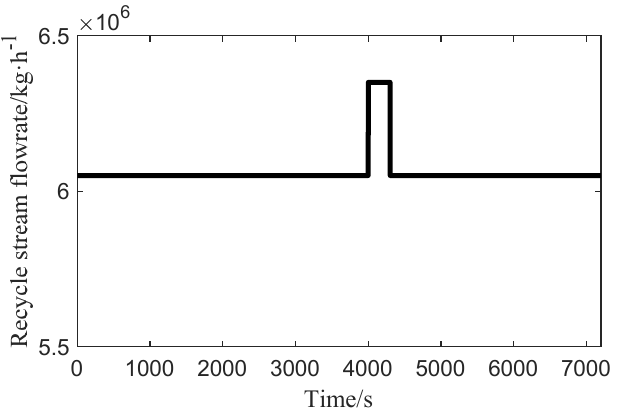
W increase. Figure 22. Disturbance of the W Re increase.